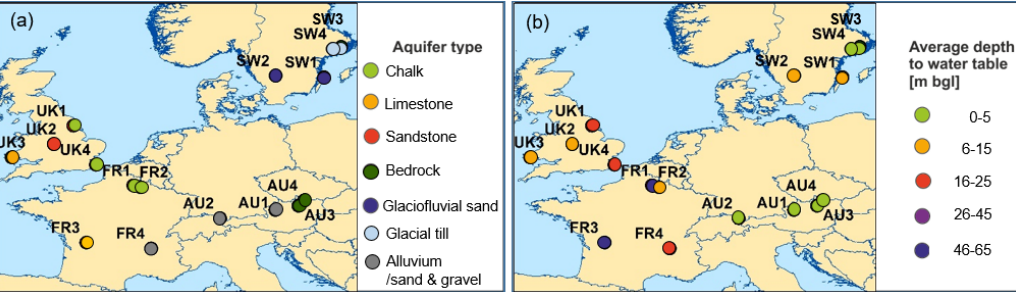
Figure 1. Site map of groundwater gauges categorized by (a) aquifer type, and (b) average depth to water table in metres below ground level (mb.g.l.). The average depth to water table was calculated based on simulated values of the site’s groundwater levels from 1955–2018. Map image is the intellectual property of Esri and is used herein under license. Copyright © 2019 Esri and its licensors. All rights reserved. Table 1. Table showing aquifer types per site, average water level in metres below ground level (m bgl; average depth was calculated based on the interpolated groundwater levels 1955–2018), maximum cross-correlation (CC) between SPI and SGI, autocorrelation range ( m max ) of the SGIs, and the accumulation period ( q max ) with maximum cross-correlation between SPI and SGI. ID Aquifer type Average WL Max m max q max (mb.g.l.) CC (months)